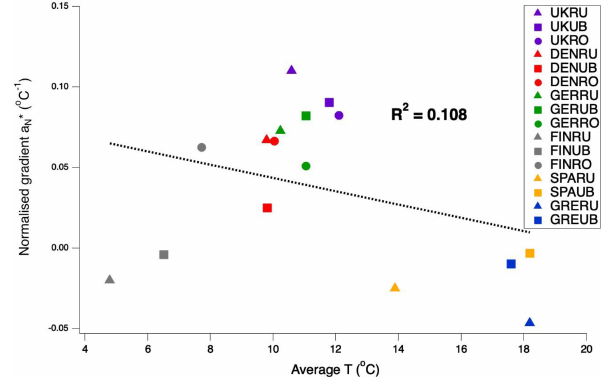
Figure 5. Relationship of average temperature and normalised gra- dients a ∗ . N